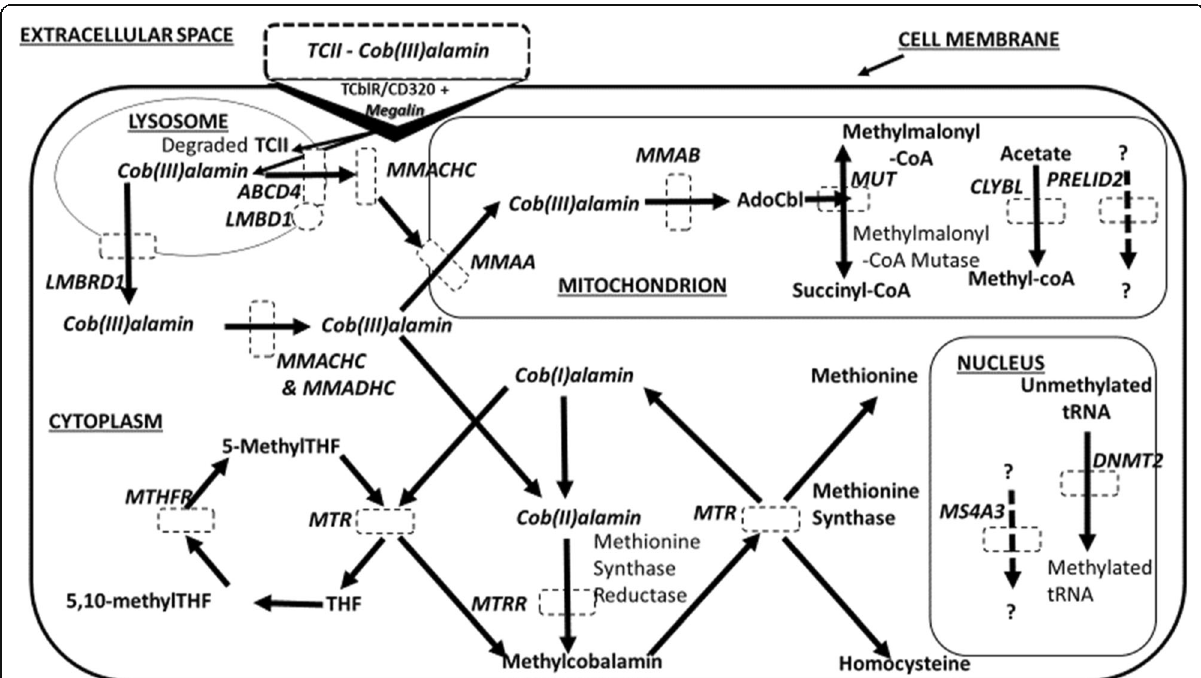
Fig. 3 Diagram representing the genes associated with vitamin B12 status. The diagram shows the proteins involved in the metabolism of vitamin B12 from the extracellular space to being internalized within the cell. Genes identified to harbour variants regulating serum levels of B12 are surrounded by dashed lines. Ado-B12 adenosyl-cobalamin; ABDC4 ATP-binding cassette, sub-family D (ALD), member 4; CD320 CD320 molecule; CLYBL citrate lyase beta like; DNMT2 DNA methyltransferase 2 gene; LMBD1 LMBR1 domain containing 1; LMBRD1 LMBR1 domain containing 1; MMAA methylmalonic aciduria (cobalamin deficiency) CblA type; MMAB methylmalonic aciduria (cobalamin deficiency) CblB type; MMACHC methylmalonic aciduria and homocystinuria, cblC type; MMADHC methylmalonic aciduria (cobalamin deficiency) CblD type, with homocystinuria; MS4A3 membrane-spanning 4-domains, subfamily A, member 3 (hematopoietic cell-specific); MTHFR 5-methyl-tetrahydrafolate reductase; MTR 5-methyltetrahydrofolate-homocysteine methyltransferase; MTRR 5-methyltetrahydrofolate-homocysteine methyltransferase reductase; MUT methylmalonyl CoA mutase; PRELID2 PRELI domain containing 2; THF tetrahydrofolate; 5,10-Methyl THF